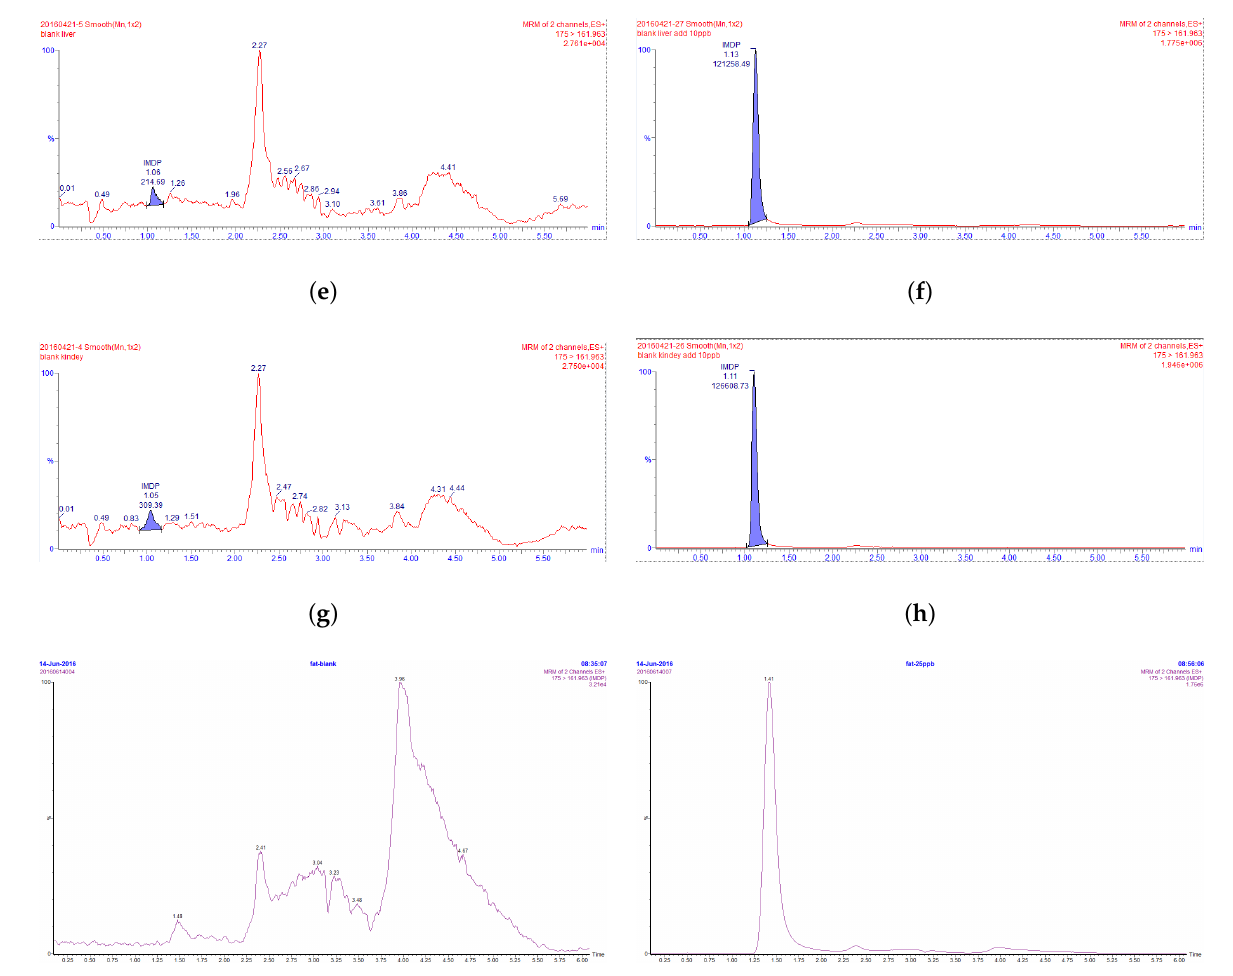
Figure 2. UPLC-MS/MS chromatograms. ( a ) for a blank mobile phase, ( b ) for a blank mobile phase spiked with IMD (10 ng/mL), ( c ) for a blank muscle tissue sample, ( d ) for a blank muscle tissue sample with IMD (10 ng/mL), ( e ) for a blank liver tissue sample, ( f ) for a blank liver tissue sample spiked with IMD (10 ng/mL), ( g ) for a blank kidney tissue sample, ( h ) for a blank kidney tissue sample spiked with IMD (10 ng/mL), ( i ) for a blank fat tissue sample, and ( j ) for blank fat tissue sample spiked with IMD (25